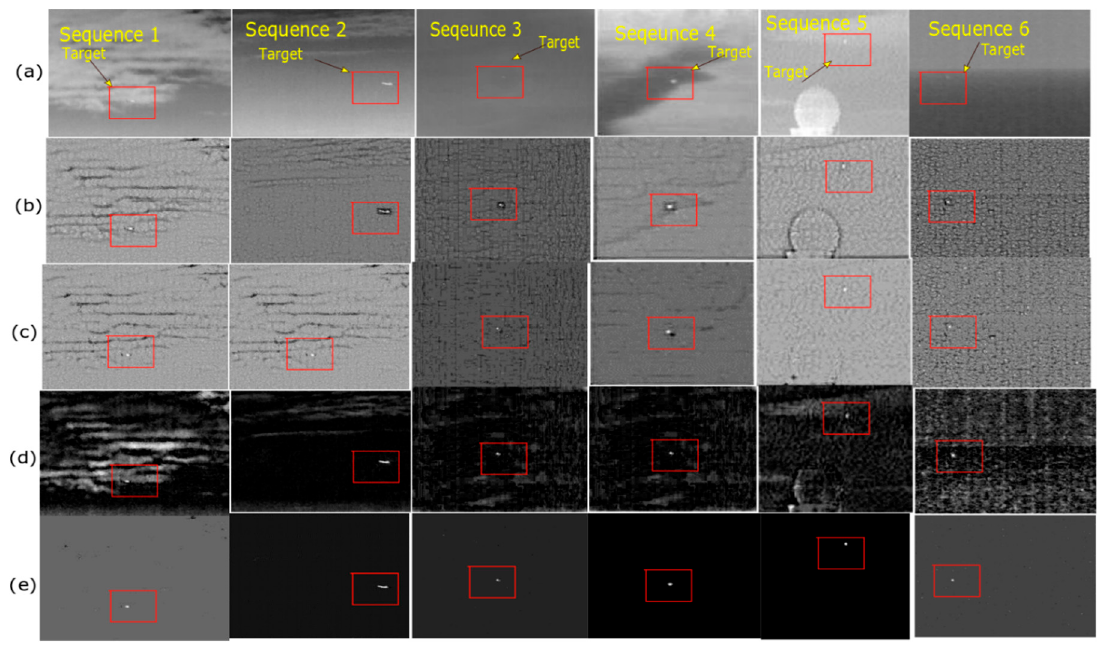
Figure 8. The target detection performances of the various methods on the image sequences presented in rows ( a – e ): ( a ) real image sequences; ( b ) max–mean; ( c ) max–median; ( d ) top-hat; ( e ) IPI.